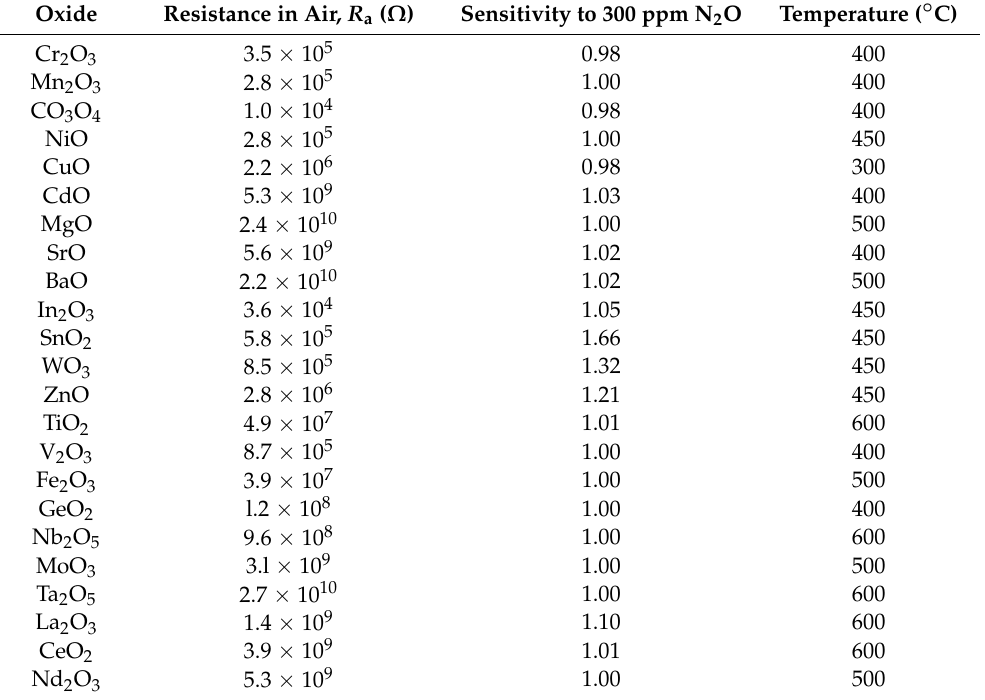
Table 6. Metal oxide sensors for N 2